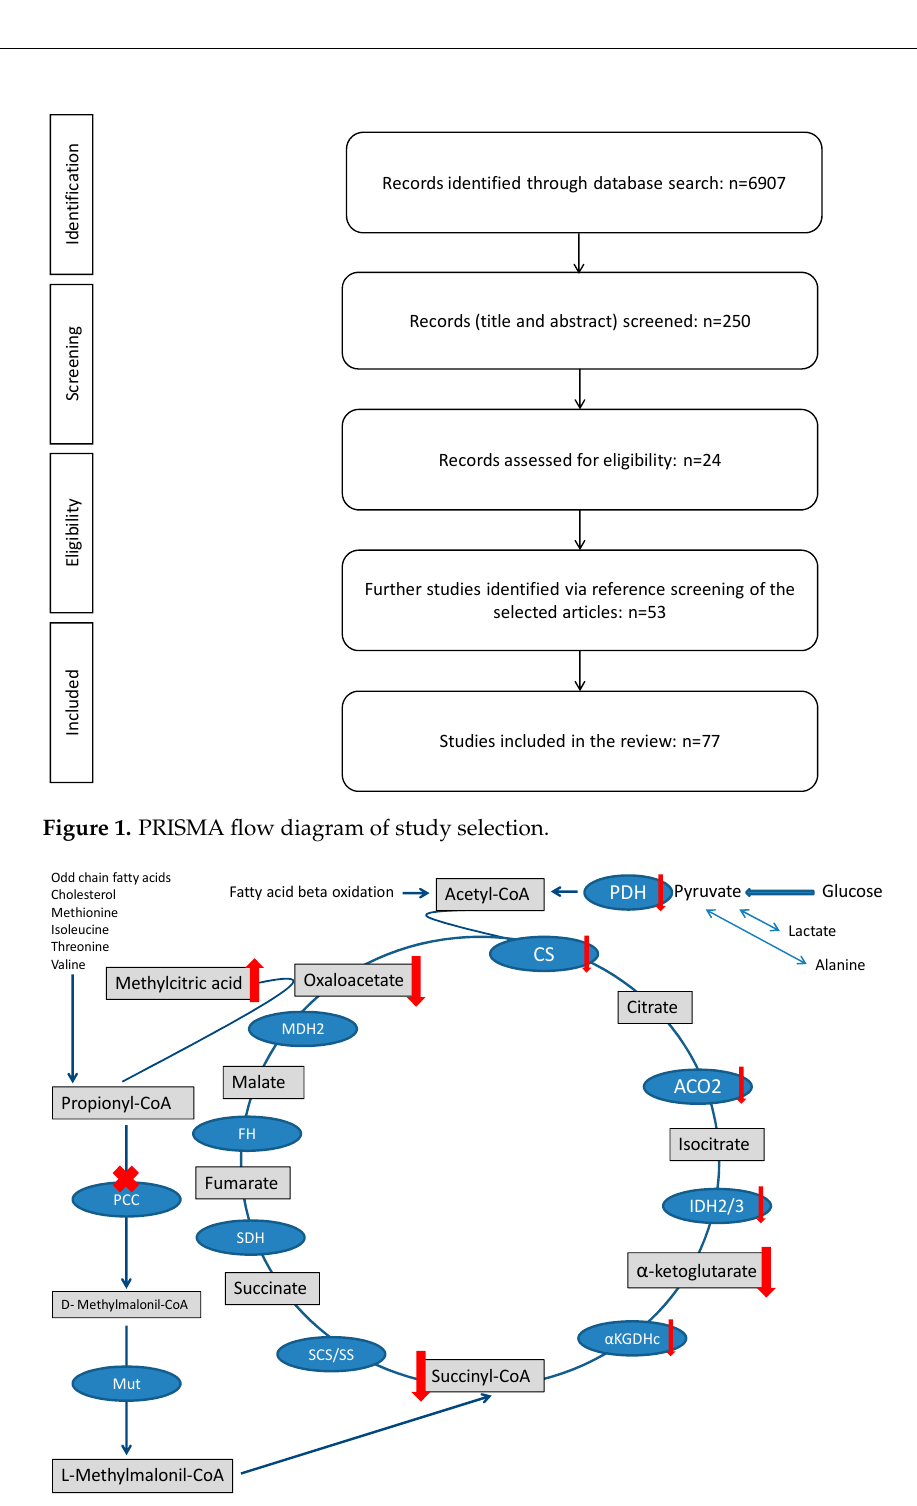
Figure 2. TCA cycle and Propionic acidemia. TCA is fed by the propionate pathway, glycolysis, and fatty acid oxidation (via acetyl-CoA). Methylmalonil-CoA mutase (Mut) is the last step in the propionate pathway and feeds succinyl-CoA into the TCA cycle. Intermediates and enzymes of interest are listed (enzymes are in the blue boxes). The ”toxin” methylcitric acid is also illustrated. Abbreviations: CS (citrate synthase), aconitase 2 (ACO2), isocitrate dehydrogenase 2/3